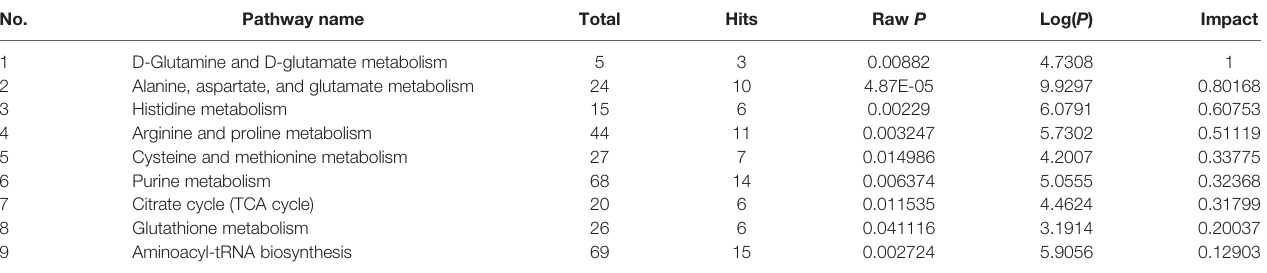
TABLE 1 | Result of metabolic pathway analysis of the altered metabolites in GDM male